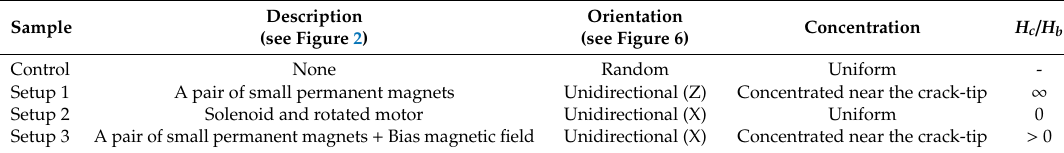
Table 1. Four categories of specimens, defined by their curing setup and by the ratio between the concentrating field ( H c ) and the bias field ( H b ) acting on the sample during curing.